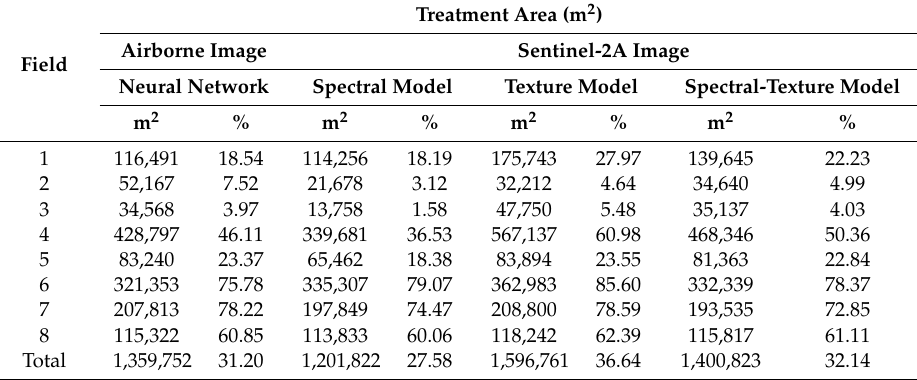
Table 7. Treatment areas of prescription maps generated from airborne and Sentinel-2A images for Fields 1–8.